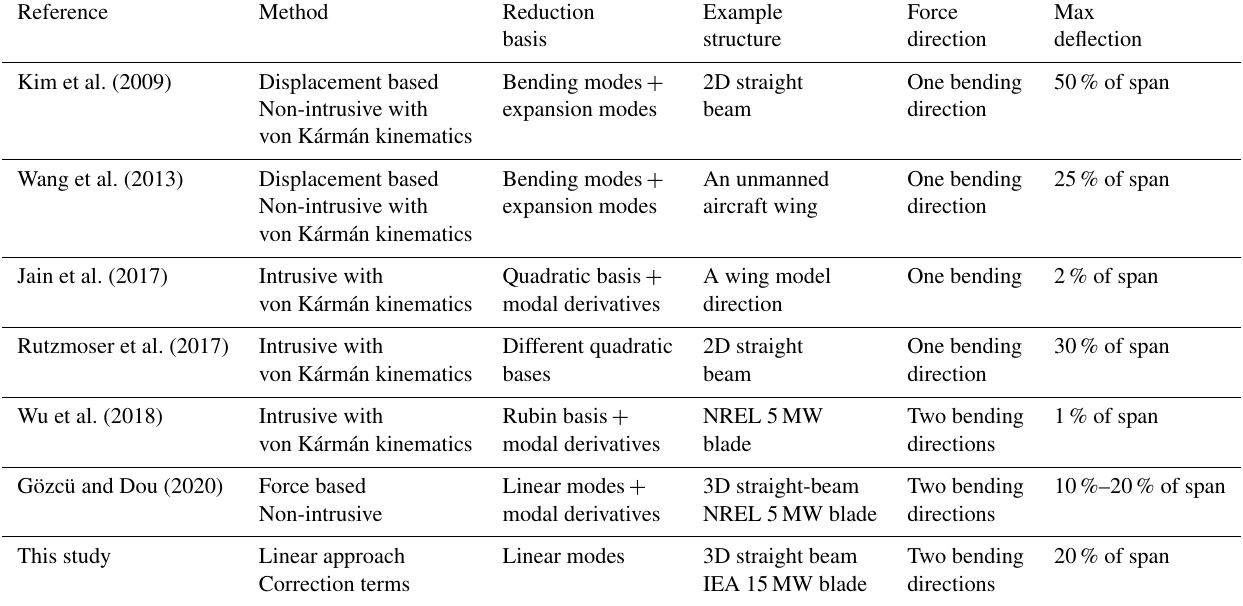
Table 1. Overview of the studies with cantilever structure models. The methods, reduction bases and example cantilever structures used in the reference studies are given together with applied forces and maximum deflections in terms of span